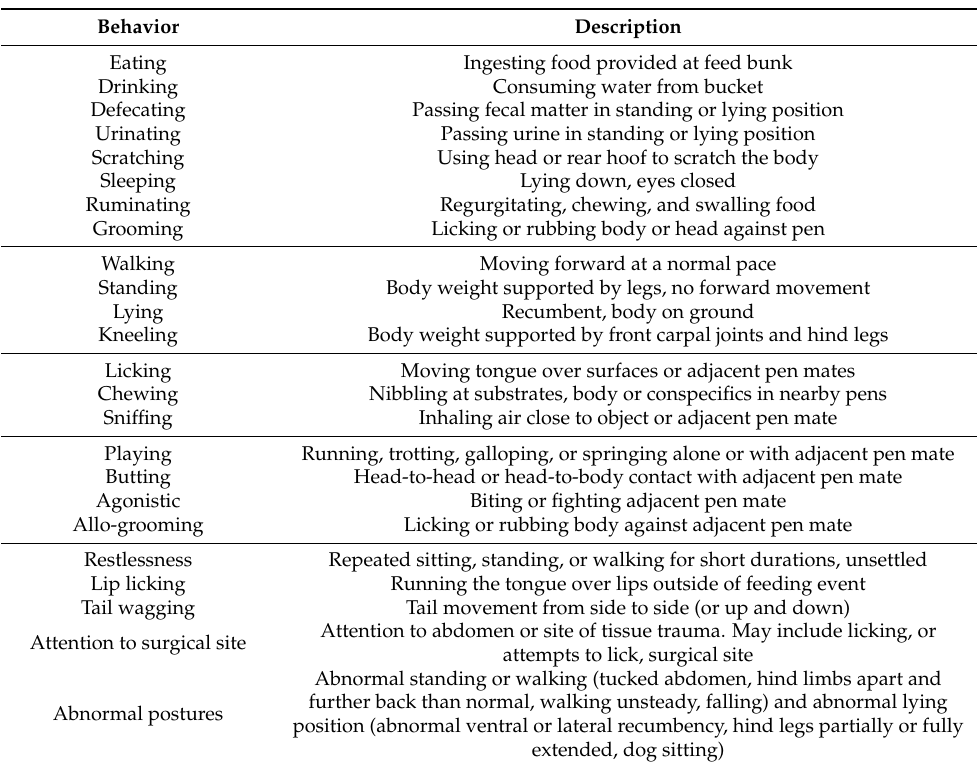
Table 1. Ethogram used to score sheep behavior, grouped into maintenance, locomotion and posture, oral and olfactory behavior, social interaction and pain behavior (adapted from studies with sheep [29,30] and dairy cows